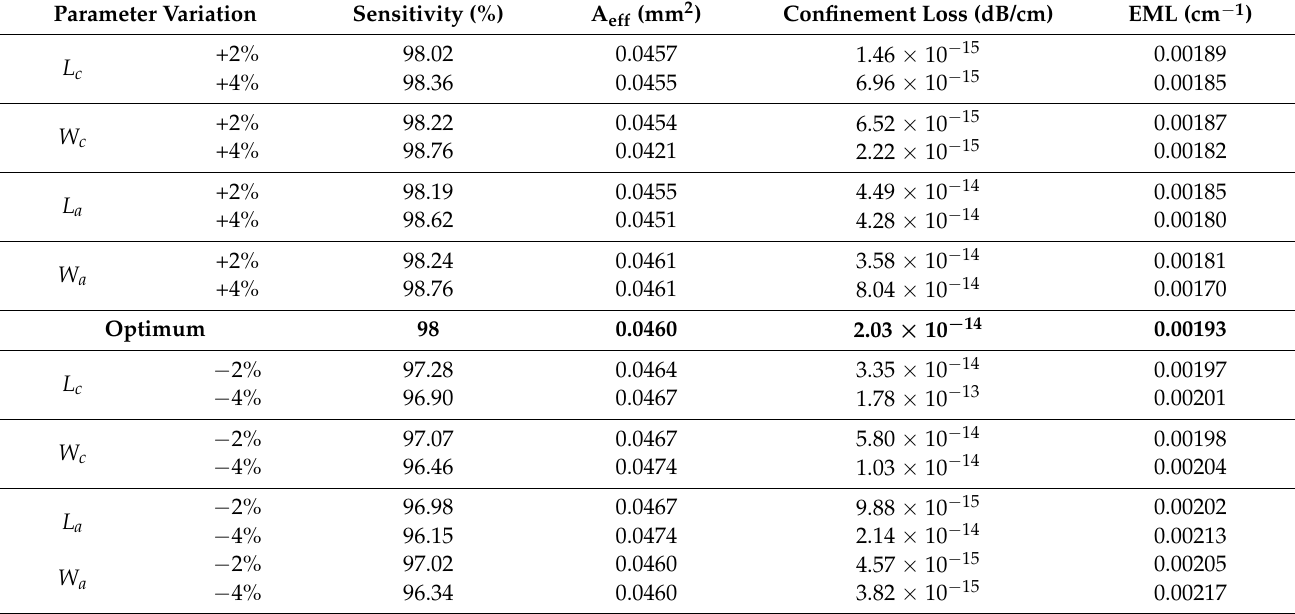
Table 3. Fabrication tolerance of the length and width of the analyte rectangle and the cladding rectangular holes of the proposed terahertz